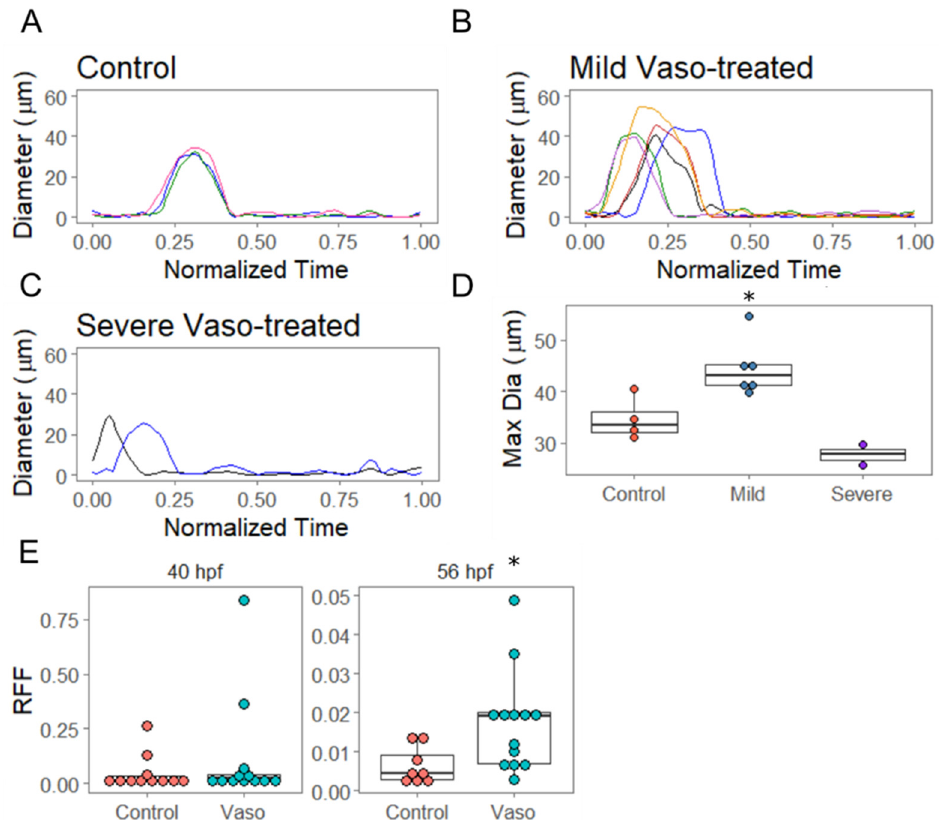
Figure 4. Increased afterload increases retrograde flow and alters AVJ mechanics. ( A ) Diameter of the flow field at the atrioventricular junction in control hearts at 56 hpf. X –axis is normalized time across a cardiac cycle, where 0 corresponds to the beginning of atrial contraction and 1 represents the end of ventricular contraction. n = 4 ( B ) Diameter analysis of vaso-treated hearts that showed hypertrophic growth between 40 and 56 hpf. n = 6 ( C ) Diameter analysis of vaso-treated hearts at 56 hpf. These hearts showed severely altered pumping mechanics at 40 hpf. ( D ) Maximum diameter analysis of control, vaso-treated hearts that showed altered pumping (AP) and vaso-treated hearts that showed hypertrophic growth (HH). ( E ) Retrograde flow fraction (RFF) at 40 and 56 hpf in control and vaso-treated hearts. n = 11 control and 12 vaso-treated fish. * indicates p < 0.05.